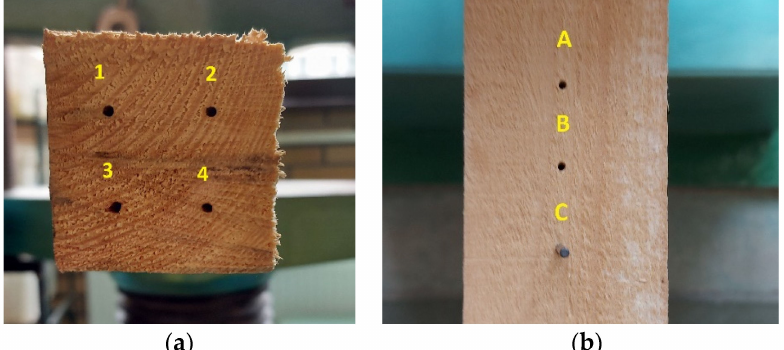
Figure 8. Measurement points—( a ) the needle recess along fibres (1, 2, 3, 4), ( b ) across fibres (A, B, C).